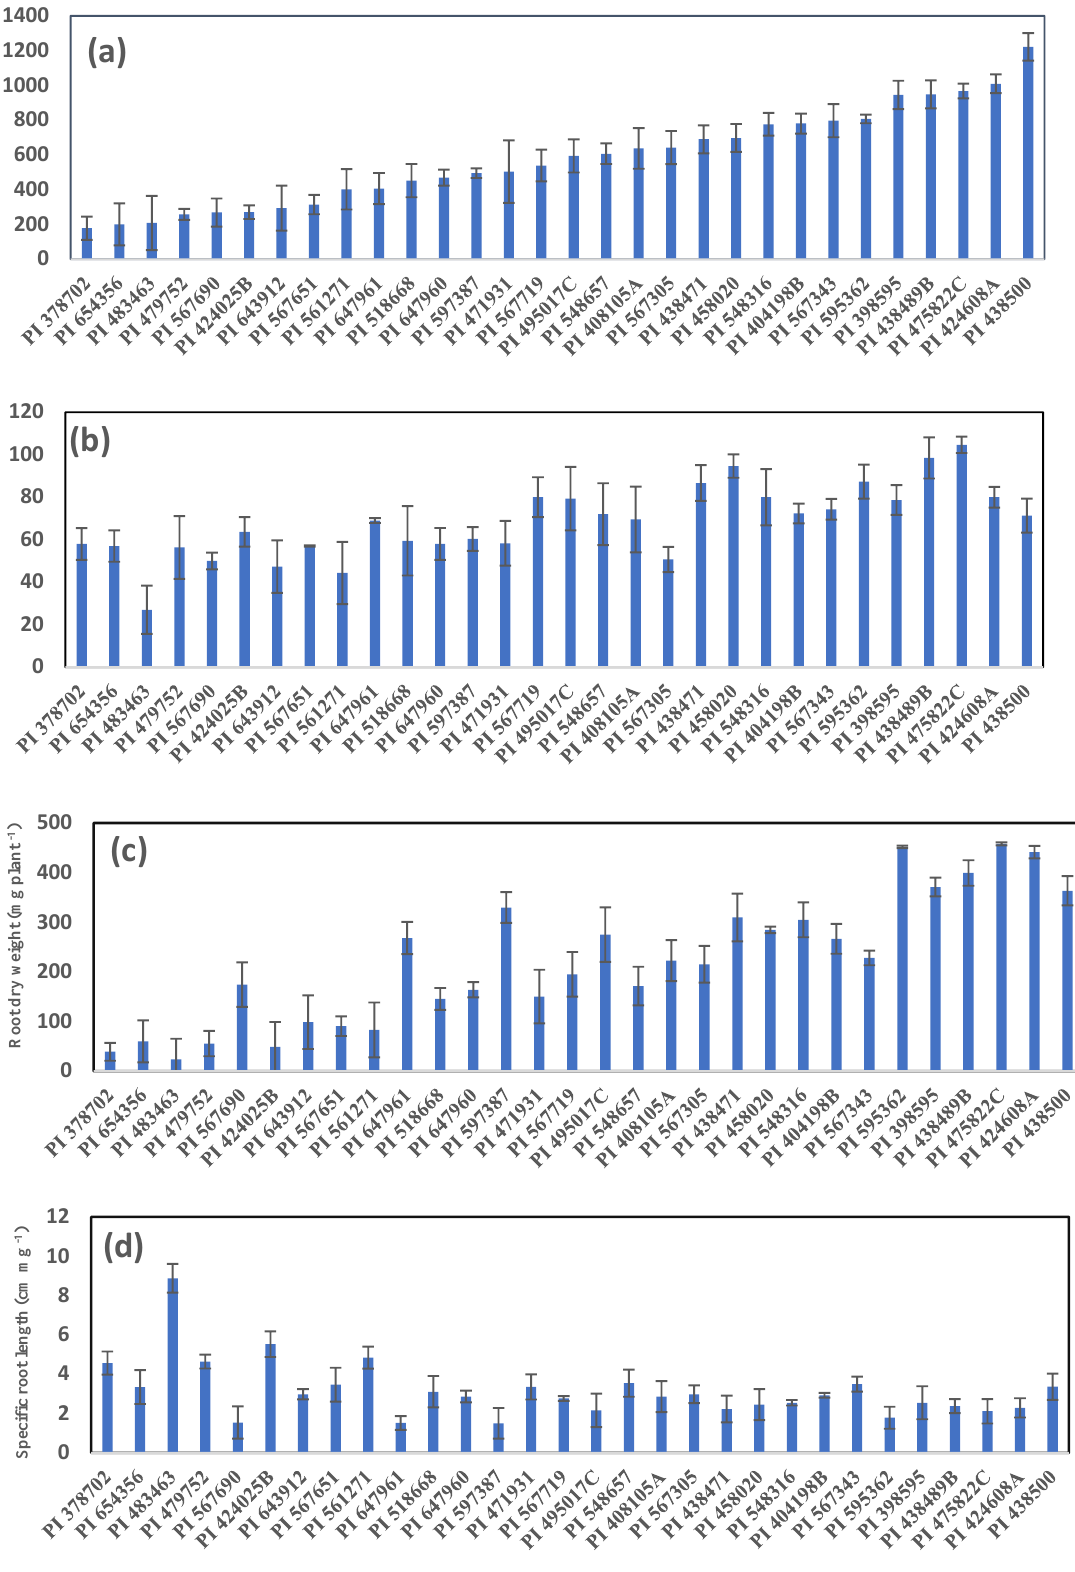
Figure 1. Genotypic variation in ( a ) total root length, ( b ) taproot length, ( c ) root dry weight, and ( d ) specific root length among 30 soybean genotypes grown in a semi-hydroponic phenotyping platform in a temperature-controlled glasshouse harvested 35 days after sowing.